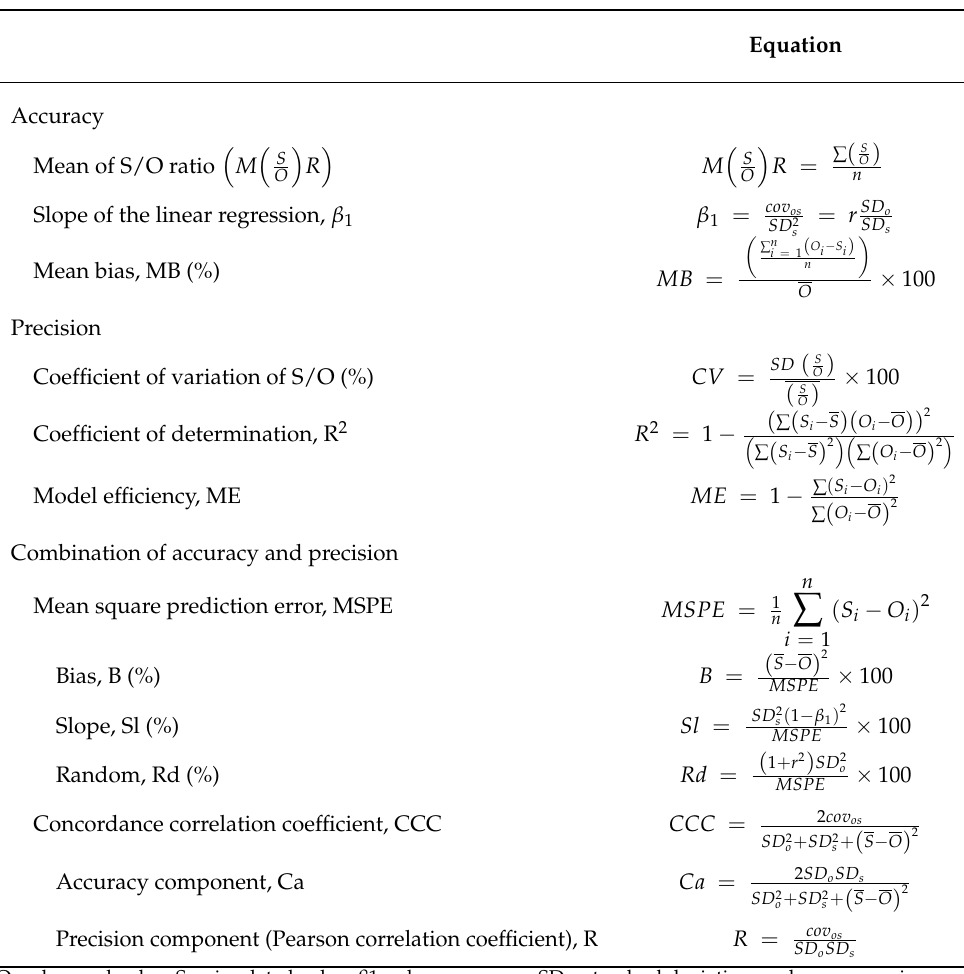
Table 2. Model accuracy and precision